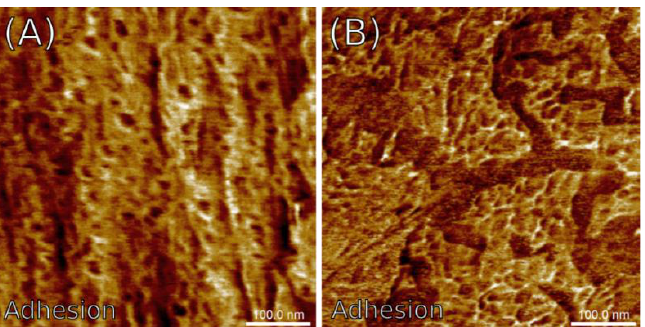
Figure 10. Exemplary maps of the adhesion force recorded in the PE7M sample: ( A ) microsection; ( B ) cross-section.